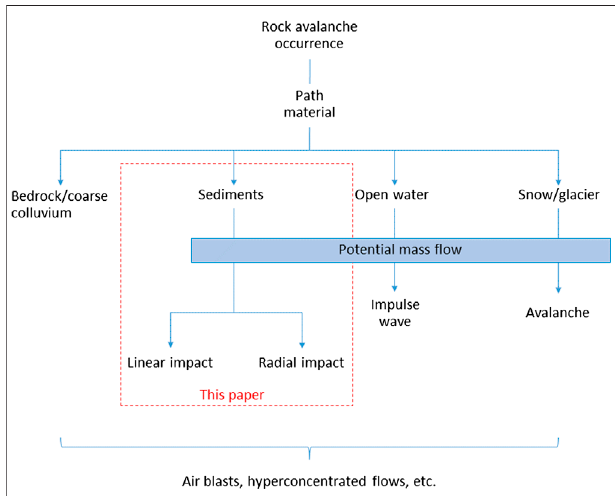
FIGURE 1 | Potential mass fl ows generated by rock avalanches. Note that multiple types of mass fl ows are possible in a single event (e.g., Bussmannand Anselmetti,2010),dependingonthenatureanddistributionof materials along the path.